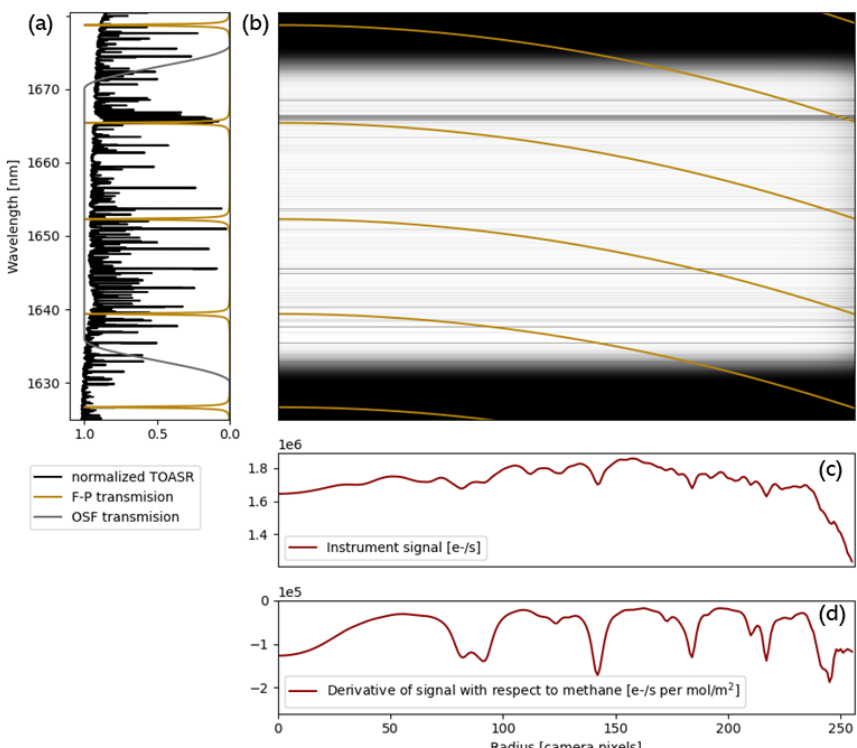
Figure 3. The plots in (a, b) illustrate how the instrument signal in (c) is produced. In (a) , the F–P and OSF transmission spectra are shown alongside the normalized top-of-atmosphere spectral radiance (TOASR) for the case of light rays incident on the F–P at normal incidence (i.e. (r,θ) = 0). In (b) , the location of the F–P transmission peaks is shown as a function of radius (gold lines) overlaid on the normalized TOASR (grayscale background image). The horizontal dark bands at the top and bottom of (b) illustrate wavelengths where the OSF transmission is reduced to zero. By sampling a continuum of incident angles θ , the transmitted F–P transmission peaks measure a continuum of wavelengths within the passband. The instrument signal (c) results from integrating the multiplied signals in (b) along the vertical (wavelength) axis. The change in instrument signal with respect to a change in the methane vertical column density is plotted in (d) . The TOASR, instrument signal, and change in signal are calculated assuming a target elevation at sea level, a solar zenith angle of 40 ◦ , and vertical column densities of 0.68 (methane), 160 (CO 2 ), and 830molm − 2 (water